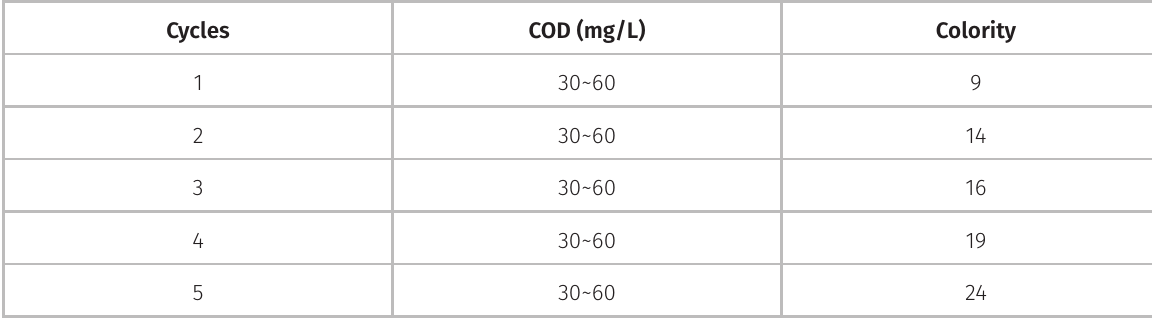
Table II. COD and colority of the permeate in five cycles by BDM GO&Laccase@UF. Cycles COD (mg/L) Colority